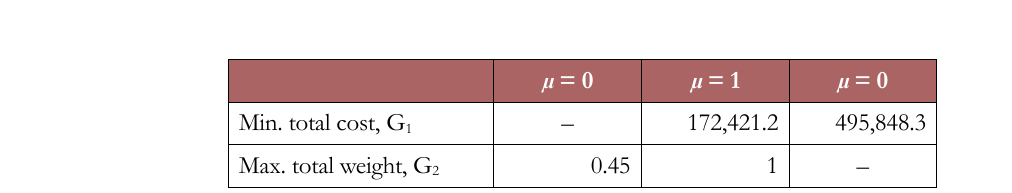
Table 7. Data set for membership functions